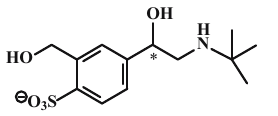
Figure 15: Structure of salbutamol sulfate.